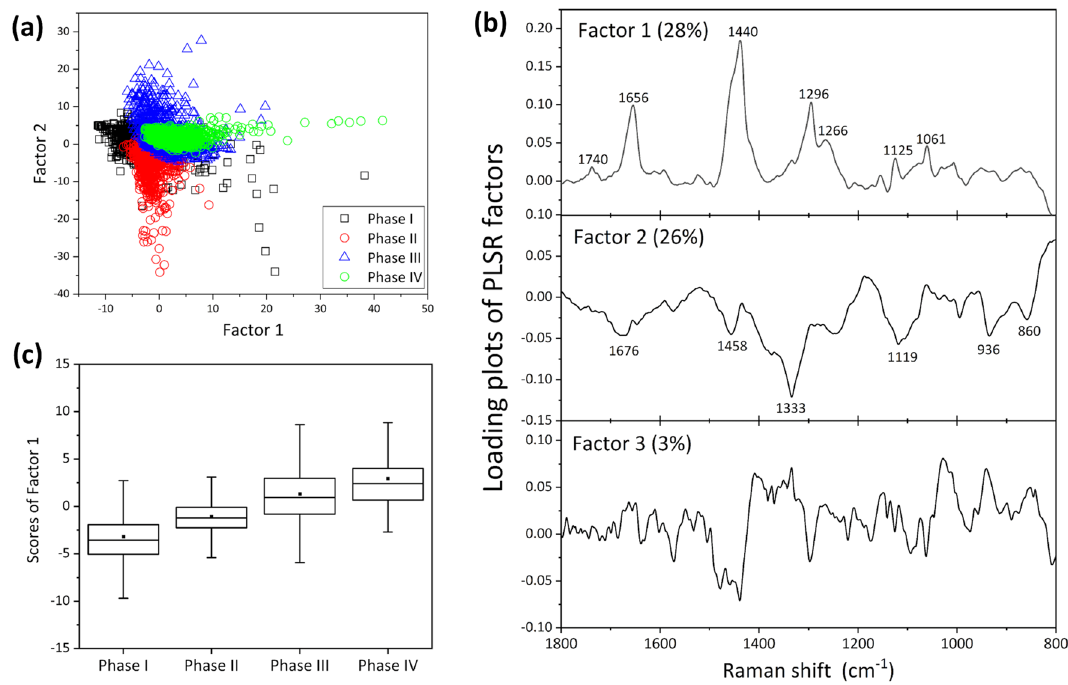
Figure 2. ( a ) Score plots of Factor 1 vs. Factor 2 and ( b ) loading plots of the main factors (up to Factor 3) for the PLS regression analysis. ( c ) Box plots of Factor 1. The box is expressed as the inter quarter range (IQR) = Q 3/4 − Q 1/4 , and is a mean value, where the central line is the mean value and the error bar shows the range between the minimum and maximum values.